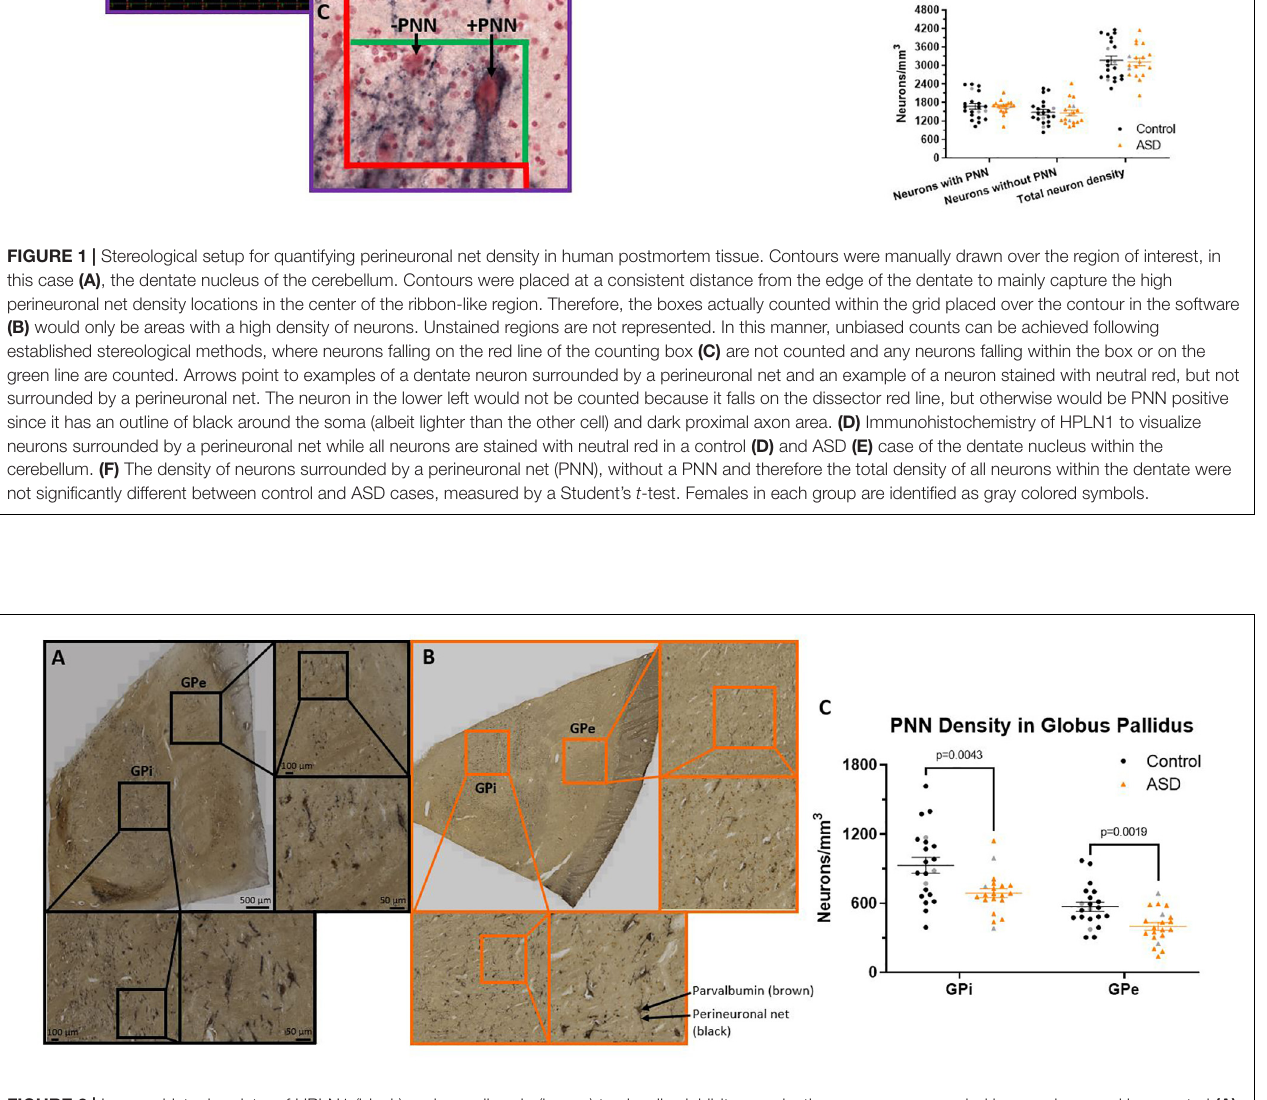
Frontiers in Molecular Neuroscience |